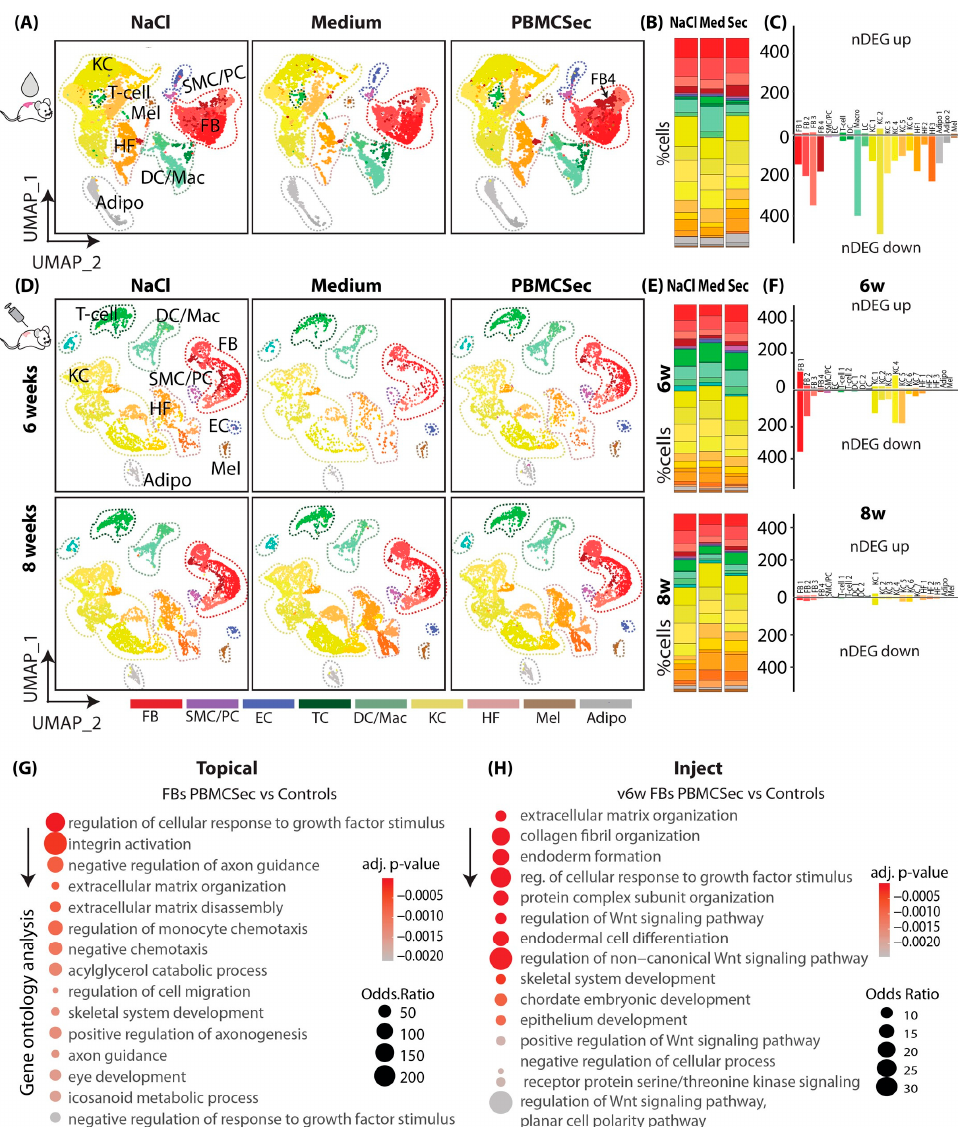
Figure 2. PBMCsec induces significant changes in the transcriptome after topical and intradermal application. ( A ) UMAP clustering of ”topical” mouse wounds (n = 4 per condition, pooled for scRNAseq analysis), split by condition: four fibroblast clusters (FB1-4; red), smooth muscle cells (SMCs) and pericytes (PCs; purple), endothelial cells (ECs; blue), T cells (TCs; dark green), macrophages (Mac) and dendritic cells (DCs; light green), three keratinocyte clusters (KC1-6; yellow), hair follicles (HF 1-3; beige), melanocytes (Mel; brown), and adipocytes (grey). Clusters were grouped as “FB”, “PC”, “TC”, “DC”, “KC”, “HF”, “MEL”, and “Adipo” for readability. ( B ) Percentages of cells per cluster, split by condition. ( C ) Number of significantly upregulated (positive y-axis) and downregulated (negative y-axis) genes (“nDEG”) per cluster in “topical” mice. ( D ) UMAP cluster- ing of “inject” mouse wounds (n = 2 per condition), split by condition, i.e., 6w = mice after two weeks of injections; 8w = mice after injections + 2 weeks of maturation. Clusters FB1–4, SMCs, PCs, ECs, T cells 1+2, DC1+2, KC1–7, HF 1–3, Mel, and Adipo. Clusters were grouped as “FB” (red), “PC” (pur- ple), “EC” (blue), “TC” (dark green), “DC” (light green), “KC” (yellow), “HF” (beige), “MEL” (brown), and “Adipo” (grey) for readability. ( E ) Percentages of cells per cluster, split by condition. ( F ) Number of significantly upregulated (positive y-axis) and downregulated (negative y-axis) genes (“nDEG”) per cluster in “inject” mice, split in 6w and 8w ( G ) Gene ontology (GO) term cal- culation of genes downregulated by PBMCsec compared with medium in “topical” FBs. ( H ) GO term calculation of genes downregulated by PBMCsec vs. medium in 6w “inject” FBs. DEGs were calculated per cluster comparing 8- and 6-week-old scars using a two-sided Wilcoxon-signed rank